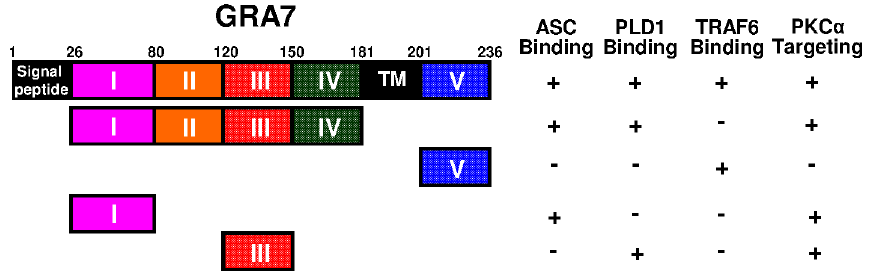
FIGURE 1: Summary of the interac- tions of GRA7 and its mutants with ASC, PLD1, TRAF6, and PKCα.